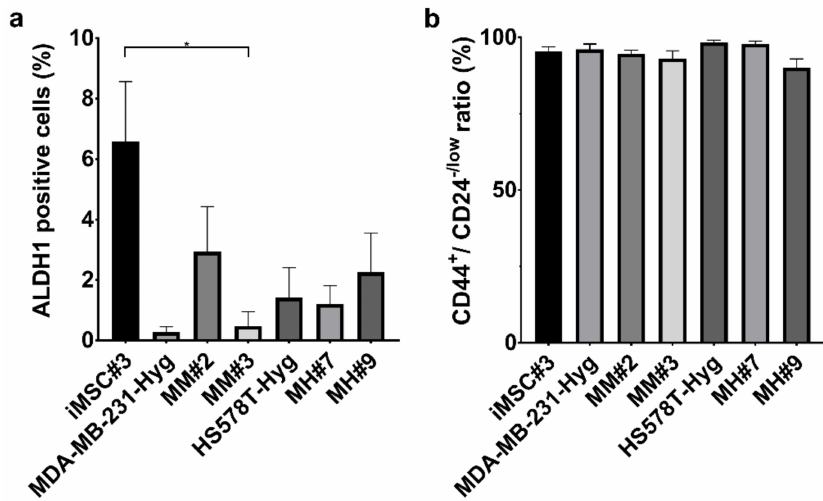
Figure 4. Analyses of di ff erent stem cell characteristics. ( a ) The number of aldehyde dehydrogenase 1 (ALDH1)-positive cells in the tested cell lines was examined using flow cytometry. Statistical analysis was performed using a one-way ANOVA and post hoc Tukey’s multiple comparison test: * = p < 0.05. ( b ) The expression of CD44 and CD24 was analyzed by flow cytometry using cells of di ff erent passages in at least three independent